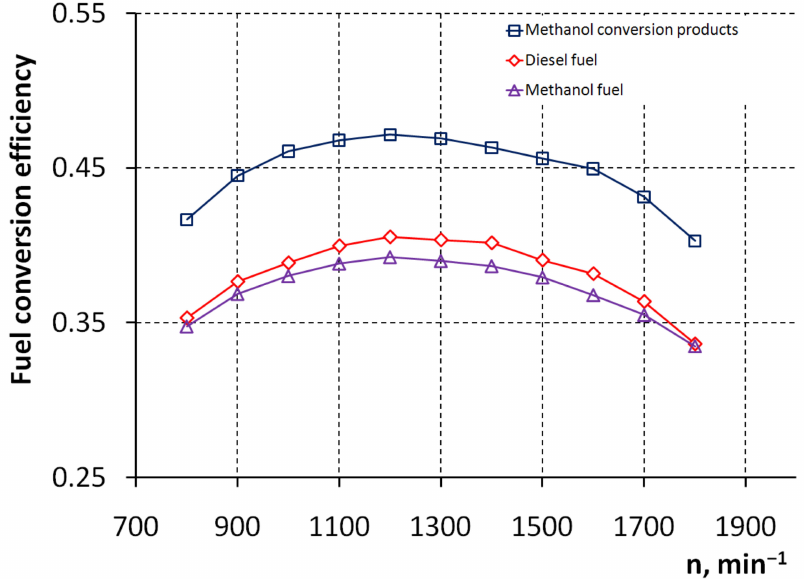
Figure 10. Energy conversion efficiency obtained for the engine fuelled with diesel fuel, methanol, and methanol conversion